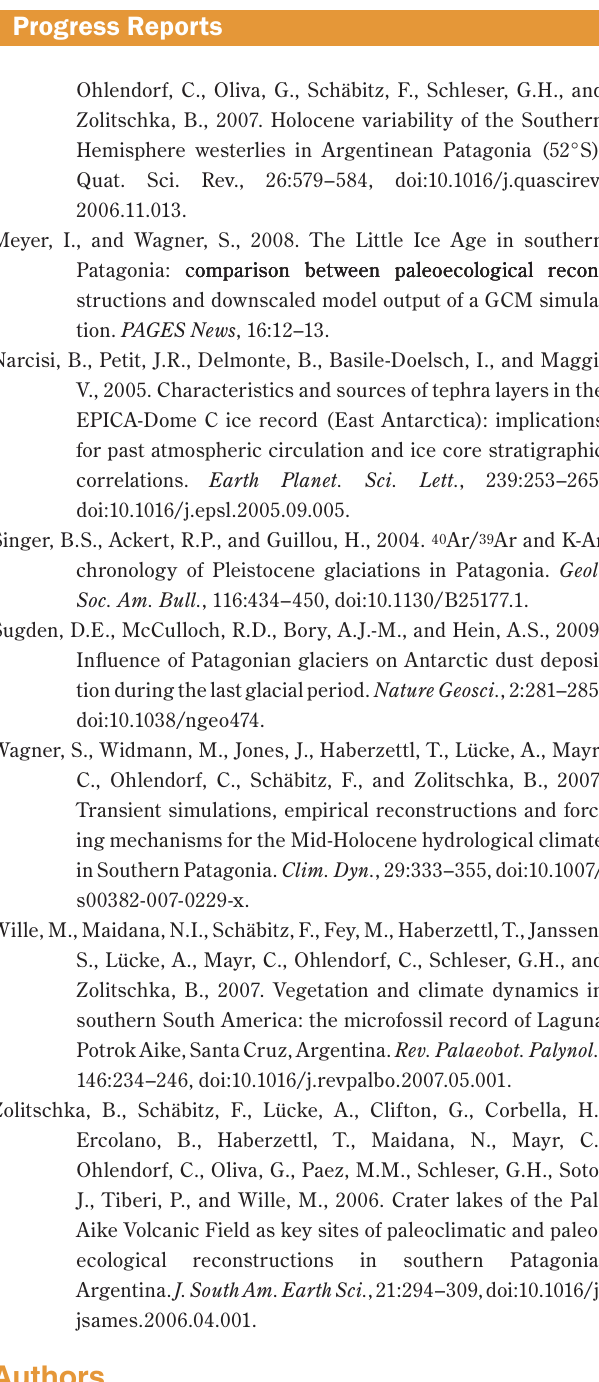
Fig. 1: Corbella, 2002 and Zolitschka et al., 2006 (both with modifications); inserted map source: Online Map Creation Fig. 2: Data by Gebhardt et al. 2009 Fig. 3: Photo by B. Zolitschka, University of Bremen Fig. 4: Photo by C. Ohlendorf, University of